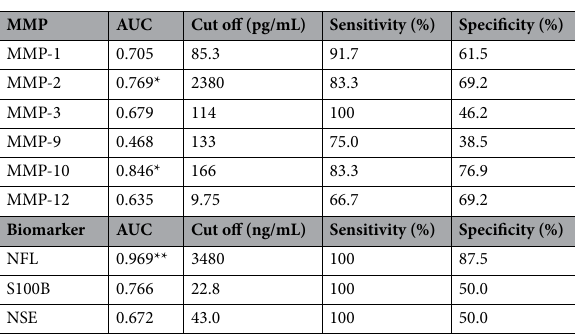
Table 2. Summary of Receiver Operating Characteristic (ROC) analysis, favourable vs unfavourable outcome following TBI, of MMPs and brain injury biomarkers in CSF. Statistical significance in the CSF analyte concentrations between favourable and unfavourable outcomes in TBI: *p ≤ 0.05. Receiver Operating Characteristic analysis was performed to predict the unfavourable outcome following TBI. AUC area under the curve, MMP matrix metalloproteinase, NFL neurofilament light, NSE neuron-specific enolase, S100B S100 calcium-binding protein B.